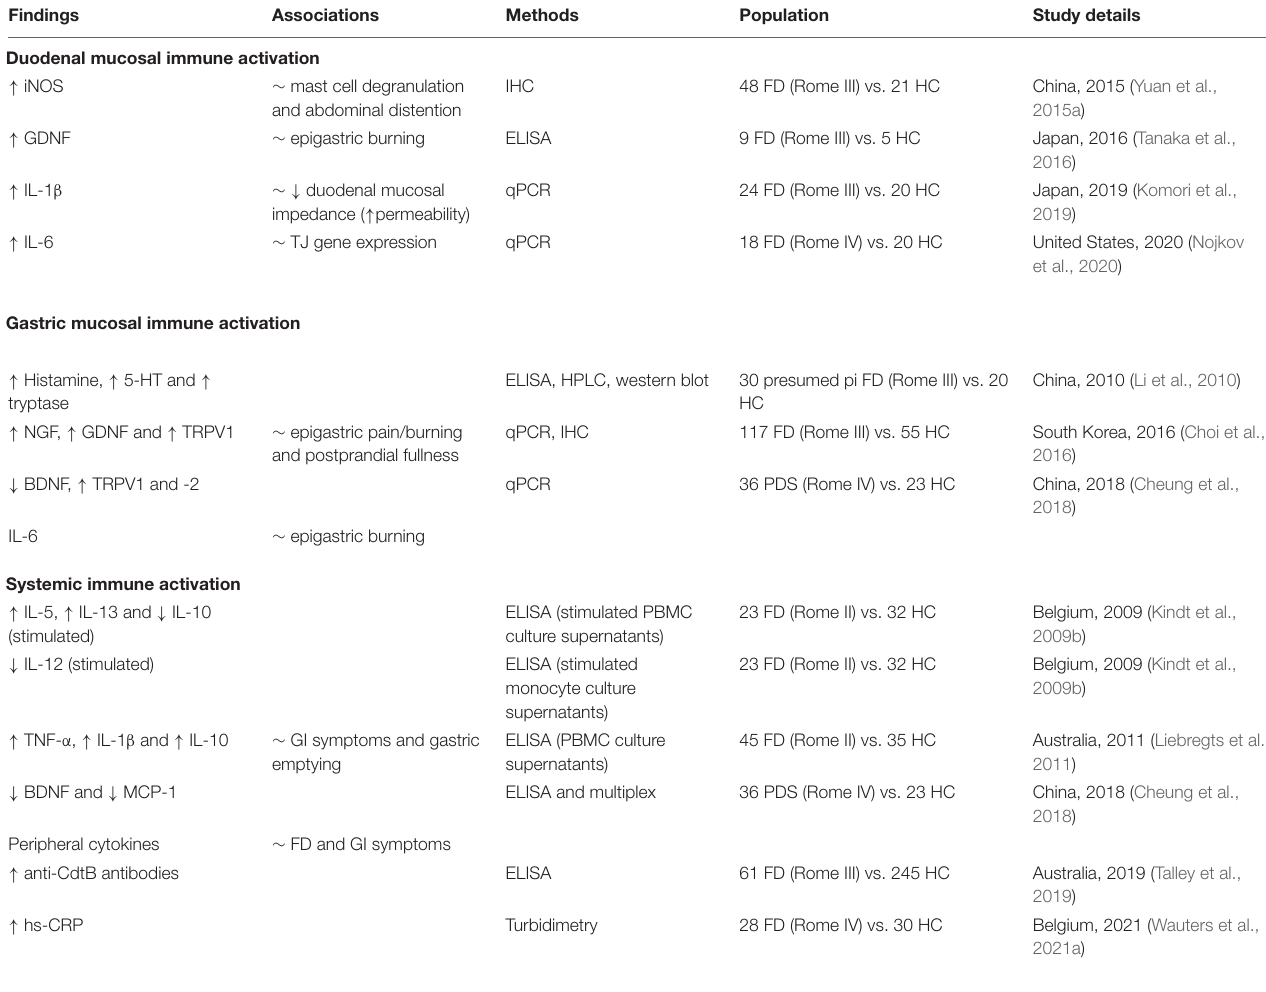
TABLE 2 | Evidence for immune activation in functional dyspepsia at the molecular